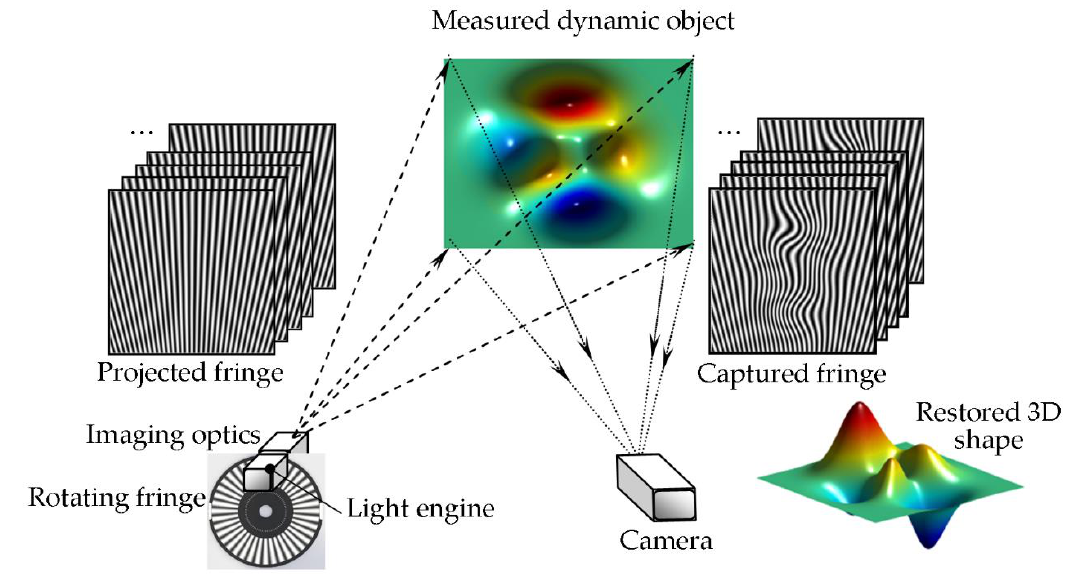
Figure 1. Schematic diagram of a typical temporal Fourier transform profilometry (TFTP)